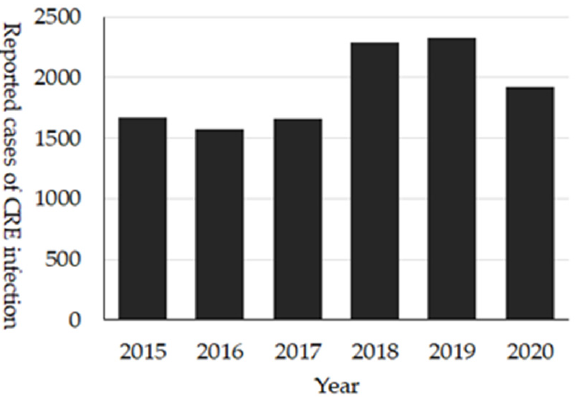
Figure 8. Number of reported cases of CRE infection, NESID 2015 to 2020.